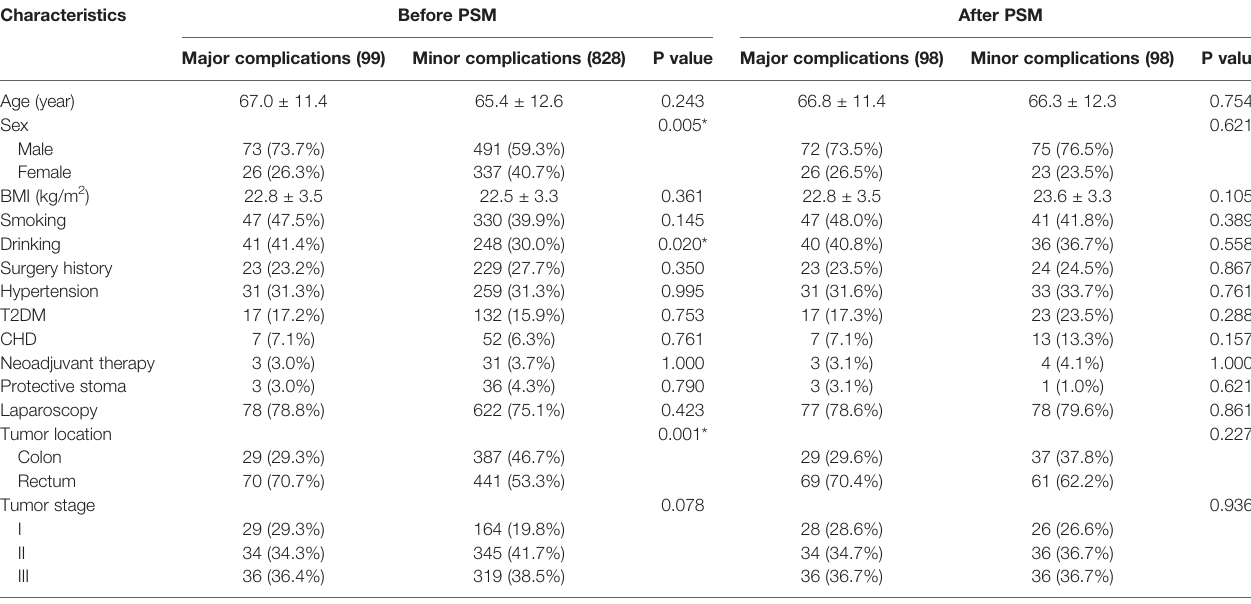
TABLE 2 | Baseline characteristics of complications before and after PSM.